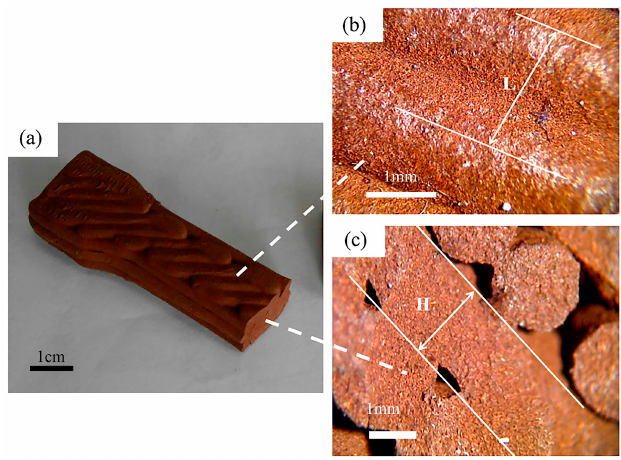
Figure 5. Green sample printed by this method: ( a ) overview; ( b ) the top surface of the green sample; ( c ) cross section of the green sample.